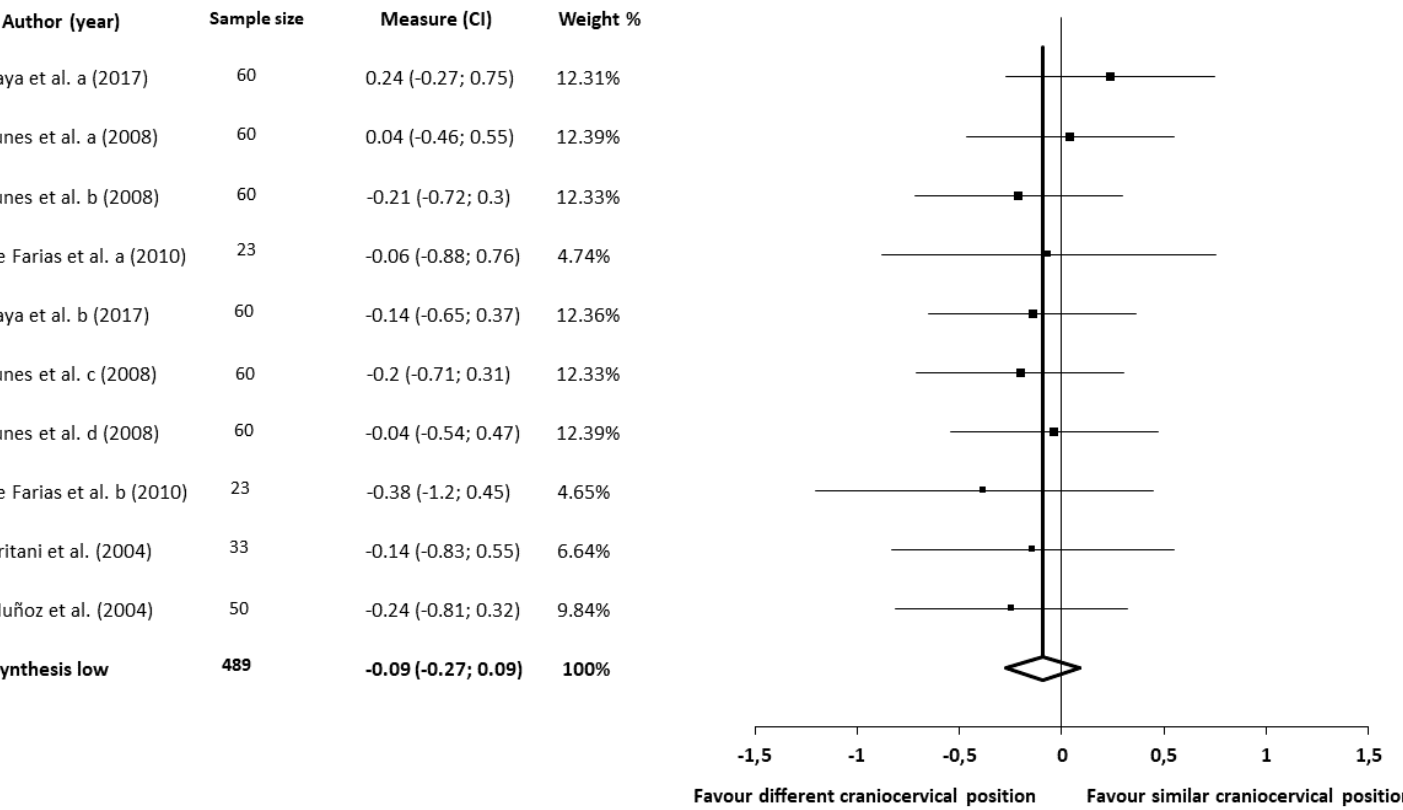
Figure 3. Synthesis forest plot for the craniocervical position. SMD, standardized mean difference. This forest plot summarizes the results of five included studies (sample size, standardized mean differences (SMDs), and weight). The small boxes with the squares represent the point estimate of the effect size and sample size. The lines on either side of the box represent a 95% confidence interval (CI). The horizontal axis represents whether the quantitative analysis is for or against the different craniocervical position in patients with TMD.